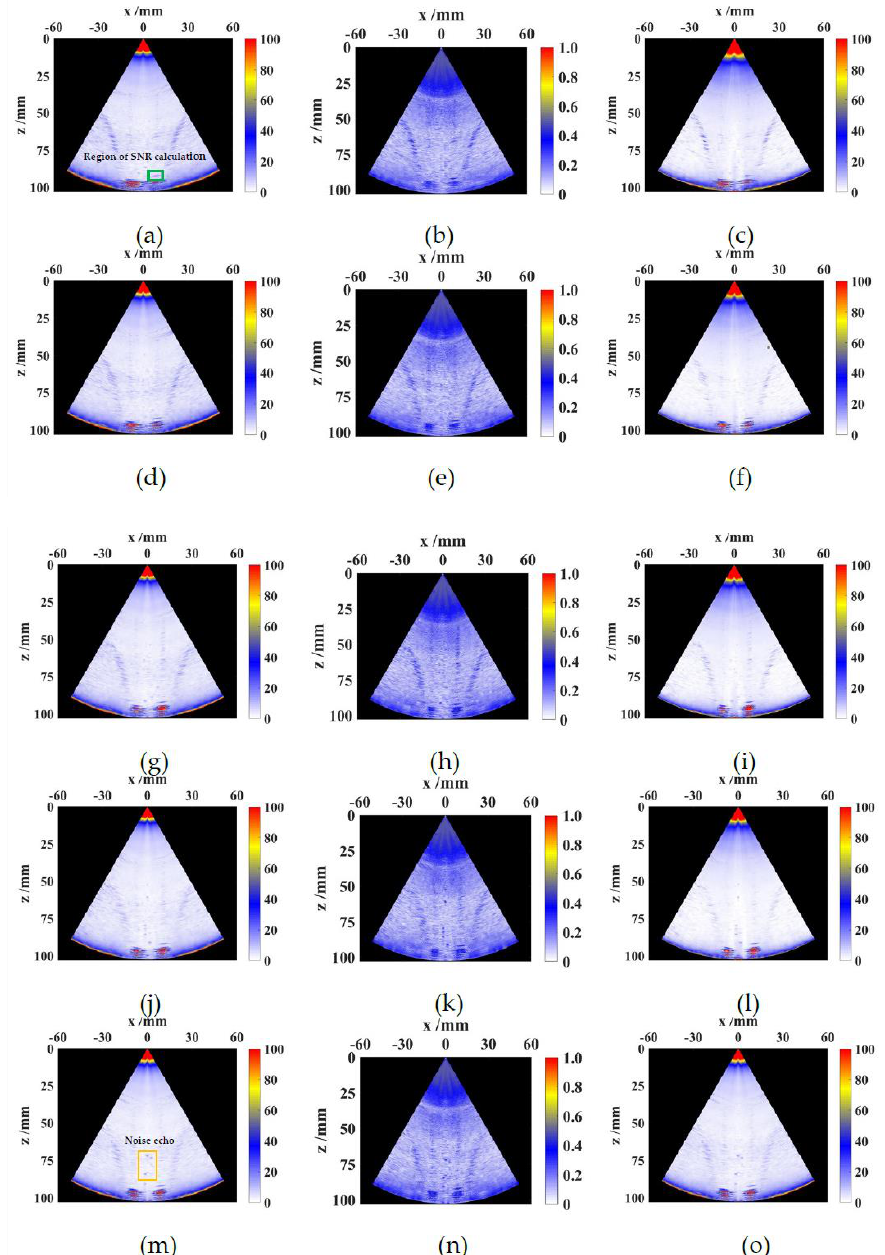
Figure 8. Imaging results of groove with depth 0.1 mm and buried depth 90 mm. ( a ) DAS, ( b ) VCF, and ( c ) DAS_VCF with focus depth 30 mm; ( d ) DAS, ( e ) VCF, and ( f ) DAS_VCF with focus depth 40 mm; ( g ) DAS, ( h ) VCF, and ( i ) DAS_VCF with focus depth 50 mm; ( j ) DAS, ( k ) VCF, and ( l ) DAS_VCF with focus depth 60 mm; ( m ) DAS, ( n ) VCF, and ( o ) DAS_VCF with focus depth 70 mm.